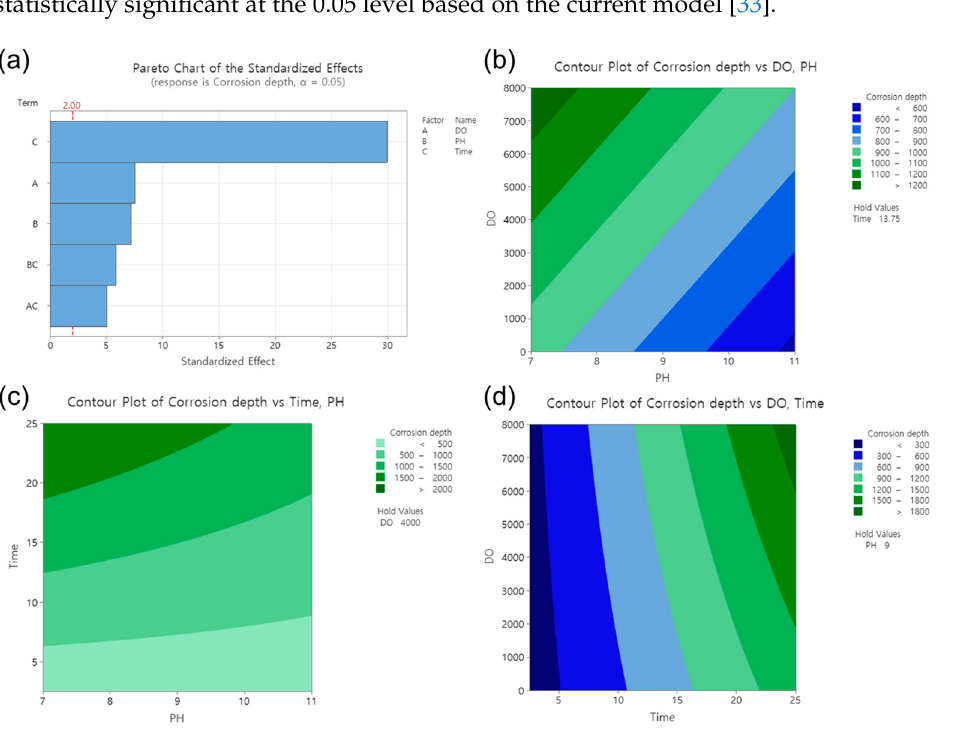
Figure 6. Effect of factors in response surface analysis. ( a ) Pareto chart of the standardized effects, contour plots of corrosion depth vs. ( b ) DO and pH, ( c ) operating time and pH, ( d ) DO and operating time.